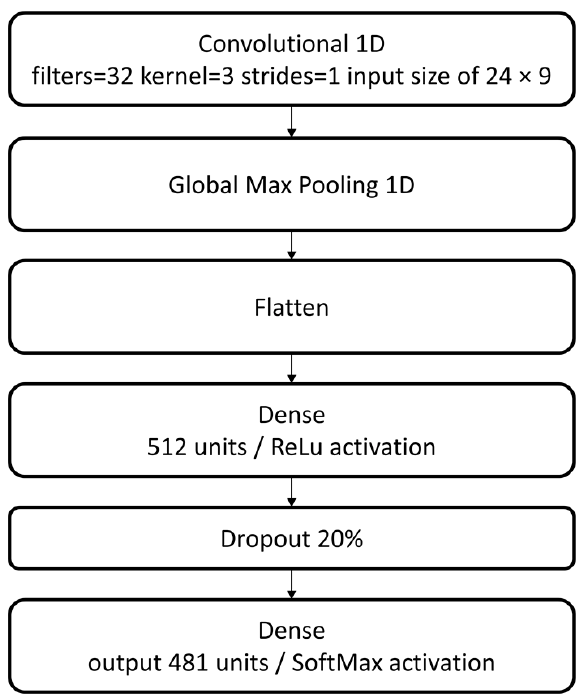
Figure 8. CNN model configuration.